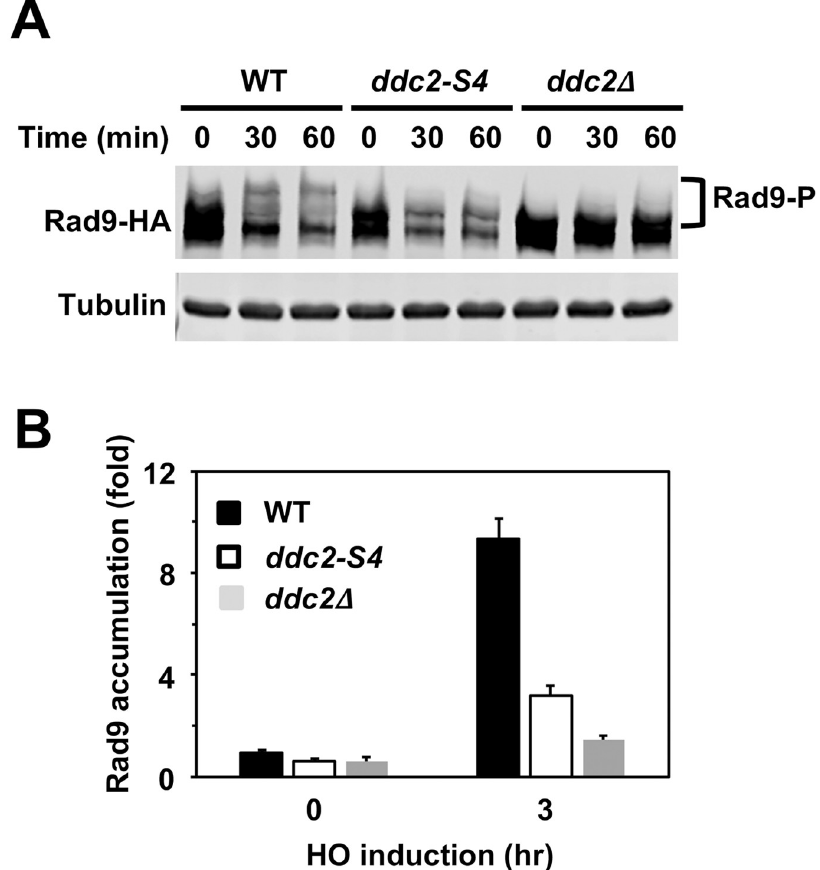
Fig 1. Effect of ddc2-S4 or ddc2 Δ mutation on Rad9 phosphorylation after DNA damage. (A) Wild-type (HB09), ddc2-S4 (HB10) or ddc2 Δ (KSC1536) cells expressing Rad9-HA were treated with nocodazole to arrest at G2/M. Cells were then exposed to 0.05% MMS. Cells were collected at the indicated time points, and extracts were subjected to immunoblotting analysis with anti-HA antibodies or anti-tubulin antibodies. (B) Effect of ddc2-S4 or ddc2 Δ on Rad9 localization to a HO-induced DSB. Wild-type (HB09), ddc2-S4 (HB10) or ddc2 Δ (KSC1536) cells expressing Rad9-HA were transformed with the YCpA-GAL-HO plasmid. Transformed cells were grown in sucrose and treated with nocodazole. After arrest at G2/M, the culture was incubated with galactose for 3 hr to induce HO expression, while half of the culture was maintained in sucrose to repress HO expression. Cells were subjected to chromatin immunoprecipitation with anti-HA antibodies. Association of Rad9 with a HO-induced DSB was analyzed by real- time PCR. Relative enrichment was determined from three independent experiments. The error bars indicate standard